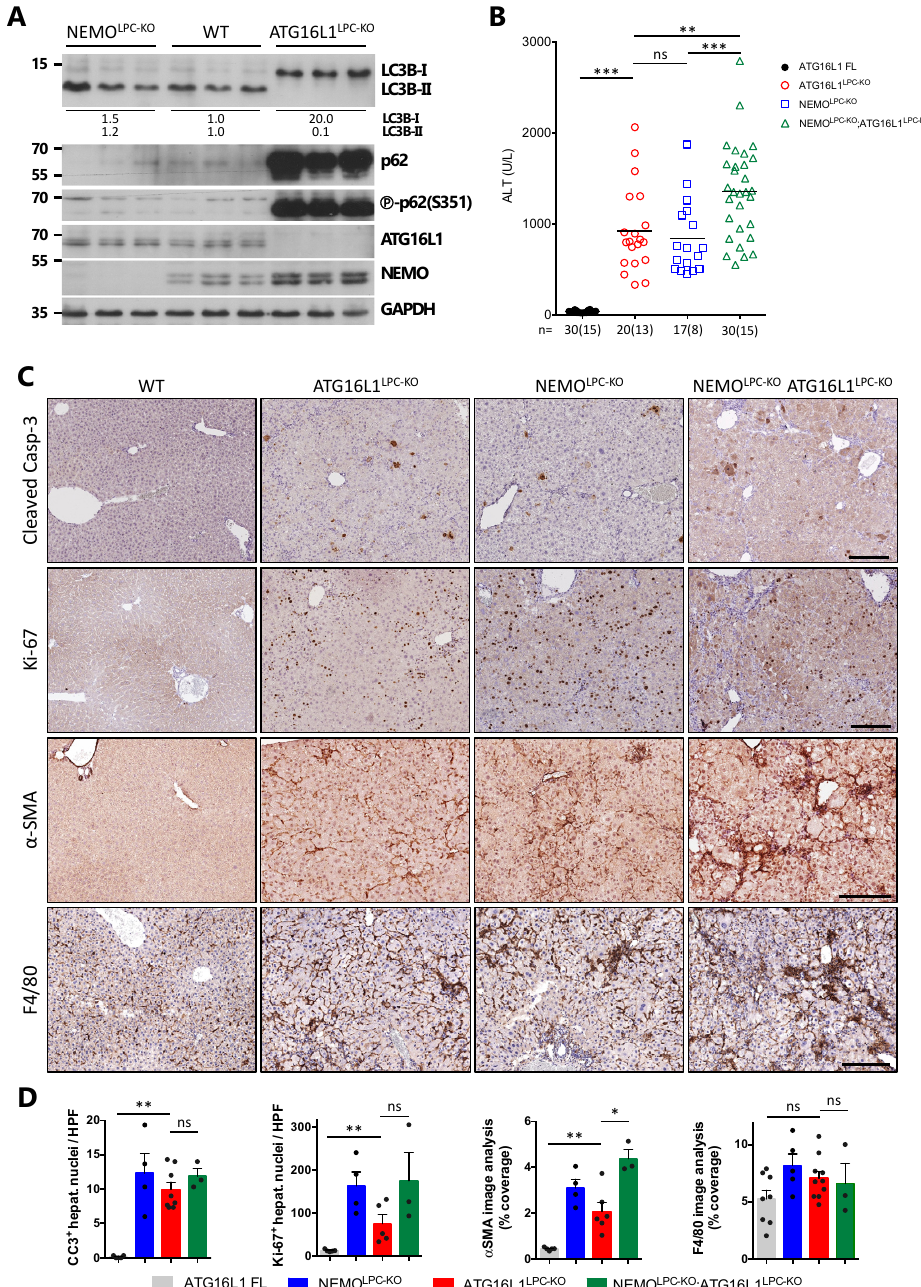
Figure 2. NEMO deficiency and autophagy inhibition independently lead to spontaneous liver damage, hepatitis and fibrosis. ( A ) Immunoblot analysis of the indicated proteins in total liver lysates from 8-week-old WT, NEMO LPC-KO and ATG16L1 LPC-KO mice. GAPDH is used as loading control. Band quantification represents the mean intensity per genotype relative to control mice and normalized to GAPDH. Uncropped scans of the immunoblots are shown in Figure S5. ( B ) Serum alanine aminotransferase (ALT) levels in 8-week-old mice with the indicated genotypes. Each symbol represents one mouse and horizontal lines indicate mean values. n indicates the number of analyzed mice, out of which the number of males is shown in brackets. ( C ) Representative images of liver sections from 8-week-old mice with the indicated genotypes after immunostaining with the indicated antibodies. ( D ) Quantification of the depicted markers in ( C ). Graphs show mean ± SEM ( n = 3–8 mice per genotype). Each dot represents the average value per analyzed mouse with the indicated genotype. ns, not significant; * p ≤ 0.05, ** p ≤ 0.01, *** p ≤ 0.005. Bars: 200 µm.